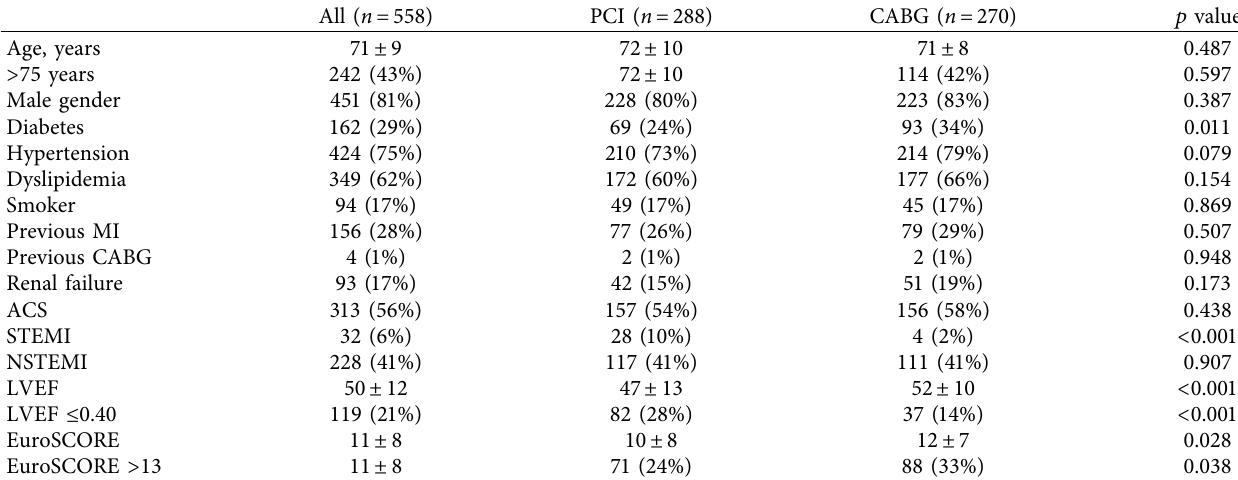
Table 1: Baseline